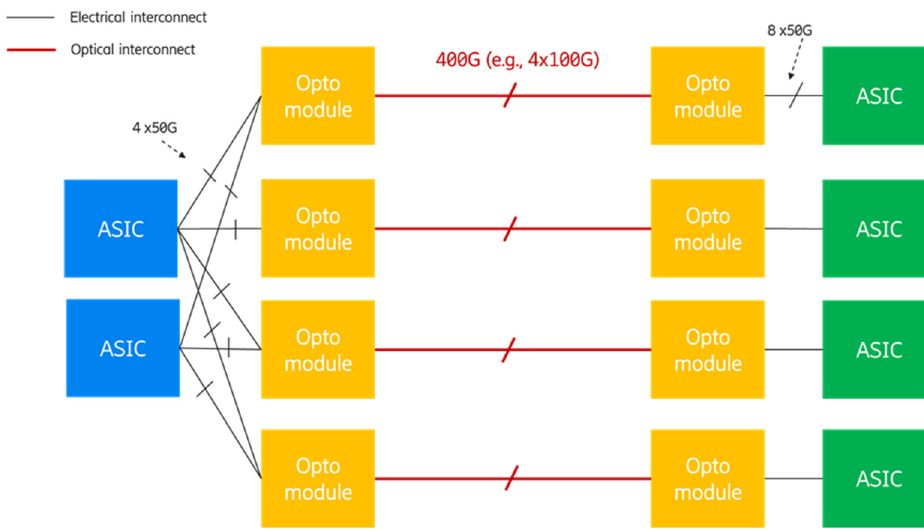
Figure 2. Possible interconnection scenario in radio systems .